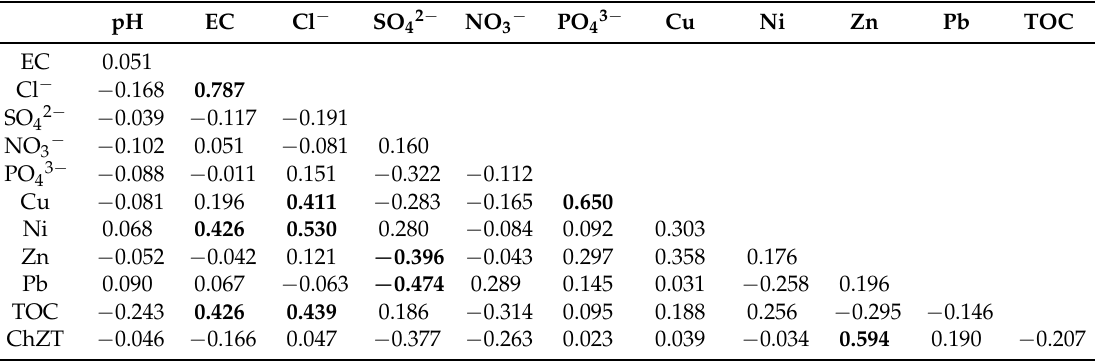
Table 2. Pearson correlation coefficient between tested parameters.